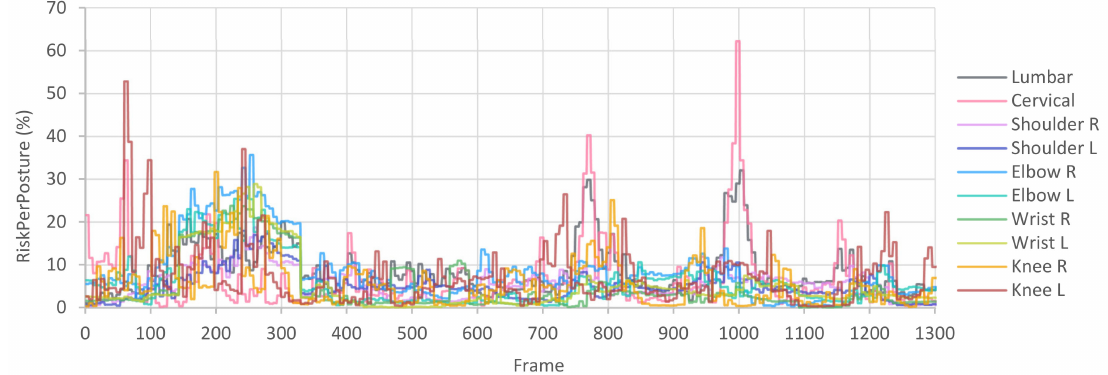
Figure 8. Results of the P003 workplace example: RiskPerPosture graph. As illustrated in Table 11, and as expected, the risks are slightly different for each situation. When the drum starts in the lower zone, the risks in the lumbar zone become maximum (yellow) due to flexion. To obtain an average RiskPerMinute value for the workstation, we combined the risks in these situations. To do this, we propose a weighted sum of the risks, assigning a weight ( W ) to each captured situation. As there are seven heights, we assume that the three intermediate heights are similar to the P003_Medium situation (3 out of 7, 42.8%), the two upper heights are similar to the P003_Top situation (2 out of 7, 28.6%), and the two lower heights are similar to the P003_Low situation (2 out of 7, 28.6%). The results are displayed in Table 11, representing the combined risk of the assumed situations, which we call P003_COMBI. Table 11. Example of the combination of workstation assessments considering a specific weight assigned to each situation. Weight